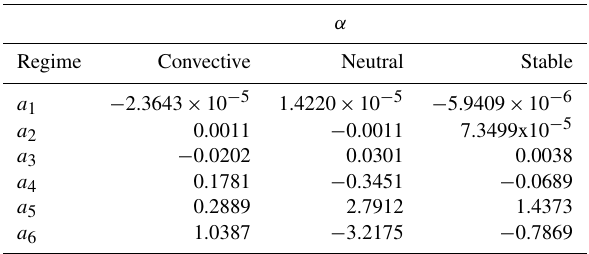
Table 5. Coefficients for fifth-order polynomial NTFs for the shear exponent.